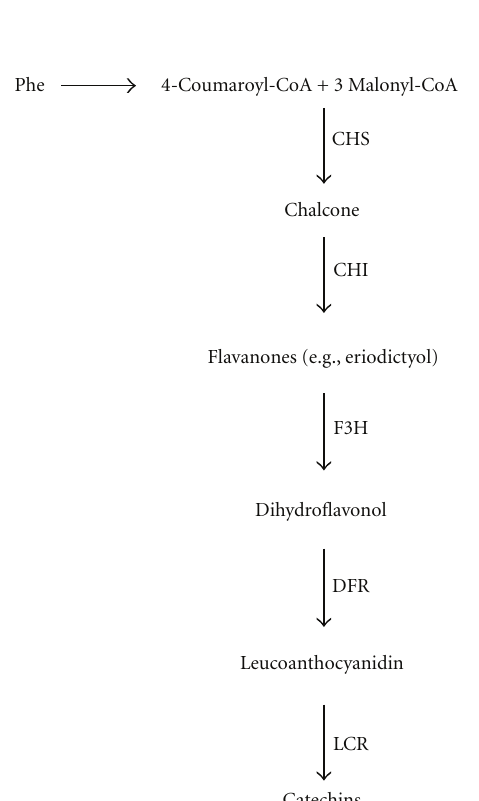
Figure 1: The proposed pathways for the biosynthesis of catechins in tea leaves. Enzymes are CHS: chalcone synthase; CHI: chalcone isomerase; F3H: flavanone 3-hydroxylase; DFR: dihydroflavonol reductase; LCR: leucoanthocyanidin reductase. (Adopted from Park et al.